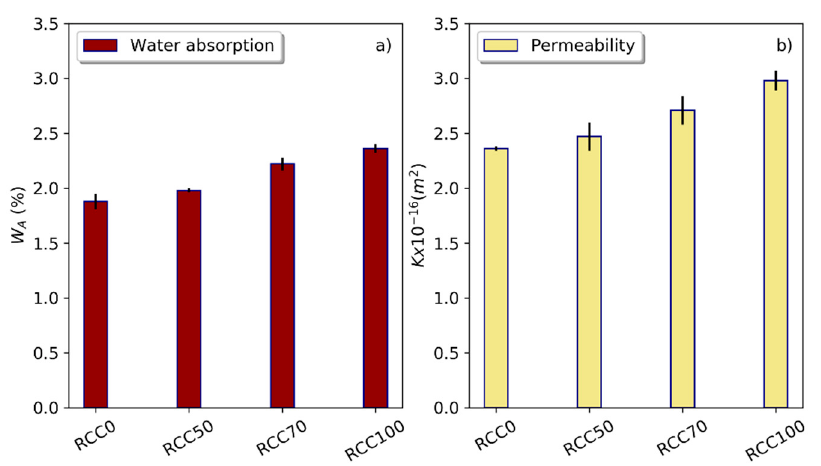
Figure 2. Physical properties, ( a ) water absorption, ( b ) gas permeability.